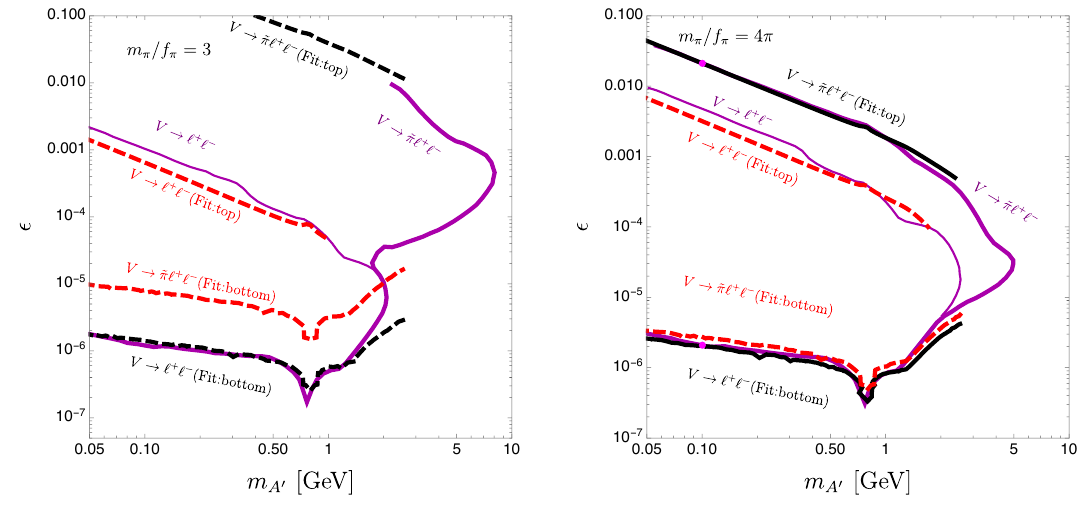
Figure 8 . Our fitting with the results of ref. [164] for SeaQuest: for fixed m π /f π = 3 (left) m π /f π = 4 π (right). The magenta lines show their results, and black and red lines show our fitting: magenta thick lines correspond to the sensitivity lines for visible decay of dark vector meson, 3-body decay ( V → ˜ π‘ + ‘ − ) and 2-body decay ( V → ‘ + ‘ − ), while magenta thin lines correspond to the sensitivity lines only for 2-body decay. We take the dark pion mass to be m = m 3 and the π A 0 / mass of the dark vector meson to be m = 0 . 6 m . We take the reference points (magenta dots in V A 0 the right panel) for our